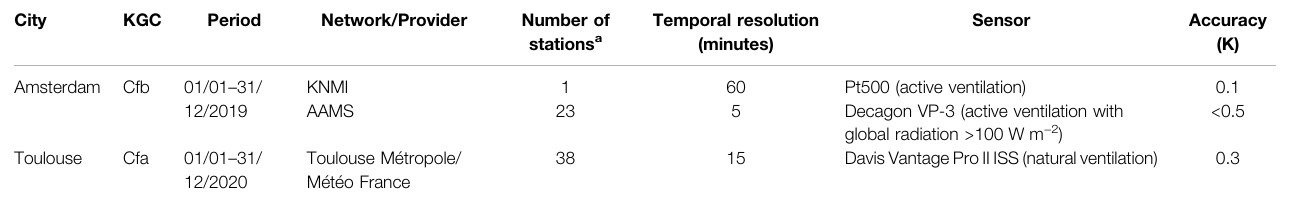
TABLE 1 | Overview of the professionally-operated weather stations in each city used in the investigations. KGC: Köppen-Geiger classi fi cation after Beck et al. (2018b). KNMI, Koninklijk Nederlands Meteorologisch Instituut – Royal Netherlands Meteorological Institute; AAMS, Amsterdam Atmospheric Meteorological Supersite (Ronda et al.,